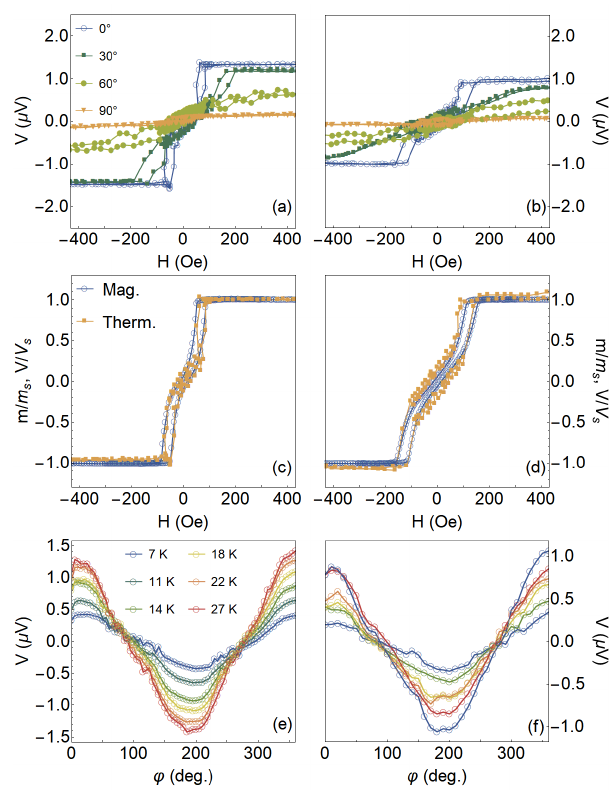
Figure 5. Experimental thermoelectric effect results. Thermoelectric voltage as a function of the magnetic field, at selected ϕ values and setting ∆ T = 27 K, for the ( a ) CFA/W bilayers in which the CFA layer was grown at ( a ) 573 K and ( b ) 673 K. ( c , d ) Comparison of the shape of normalized magnetization and thermoelectric voltage curves acquired at ϕ = 0 ◦ , with ∆ T = 27 K, for these samples. ( e , f ) Angular dependence of the thermoelectric voltage at H = + 500 Oe for distinct ∆ T values for the very same